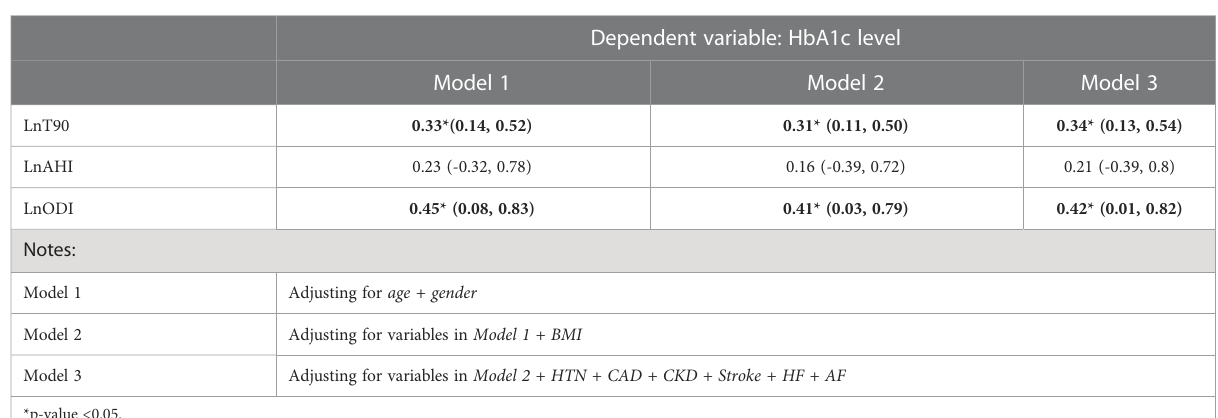
TABLE 3 Multivariate